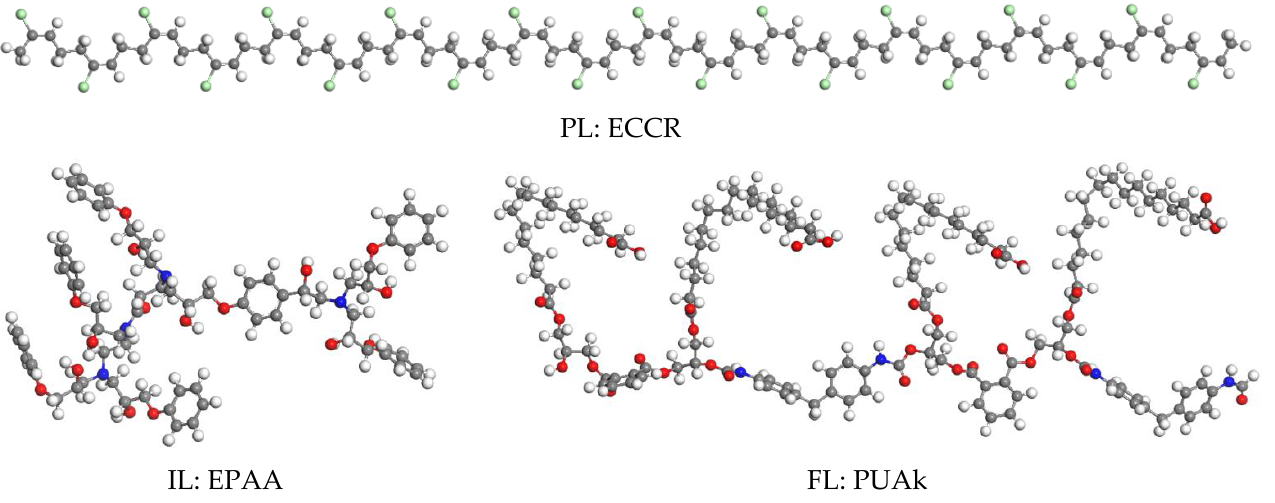
Figure 1. Optimized structures of the polymers constituting the three coating layers (PI, IL, FL).